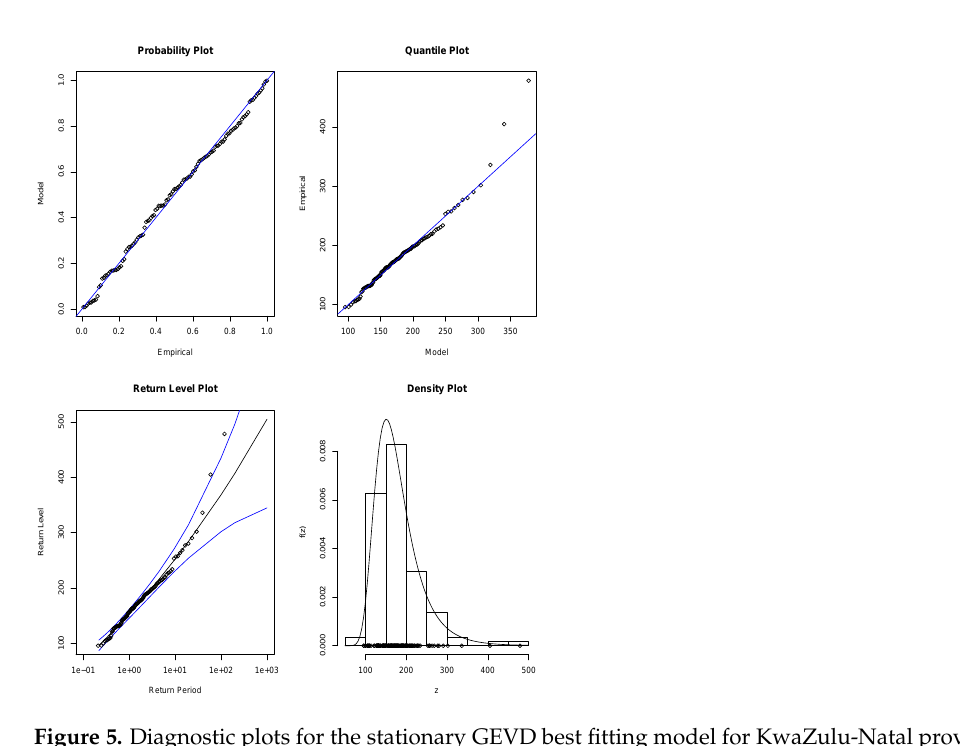
Figure 5. Diagnostic plots for the stationary GEVD best fitting model for KwaZulu-Natal province. Goodness-of-fit test for KwaZulu-Natal GEVD model